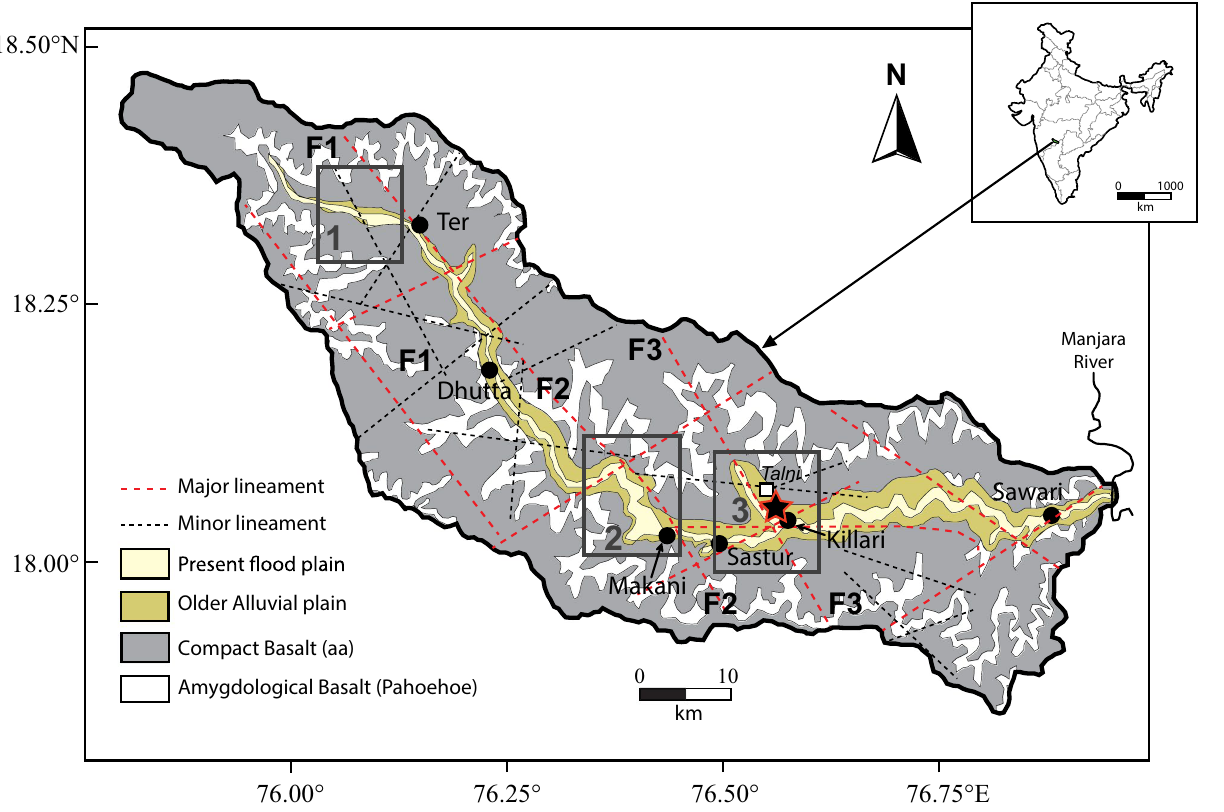
Figure 1. Geological map of the Tirna River basin showing the lineaments and location of studied outcrops (modified after Chetty and Rao 13 and Babar et al 19 ). The major (red dashed lines) and minor (black dashed lines) lineaments occurring along NE–SW, NW–SE, E–W and WNW–ESE directions. The sampling sites are: Ter, Dhutta, Makani, Sastur, Killari and Sawari. Red Star indicates epicenter of 1993 Killari Earthquake (M w = 6.1). The dextral displacements of the Tirna River faults are shown in F1 and